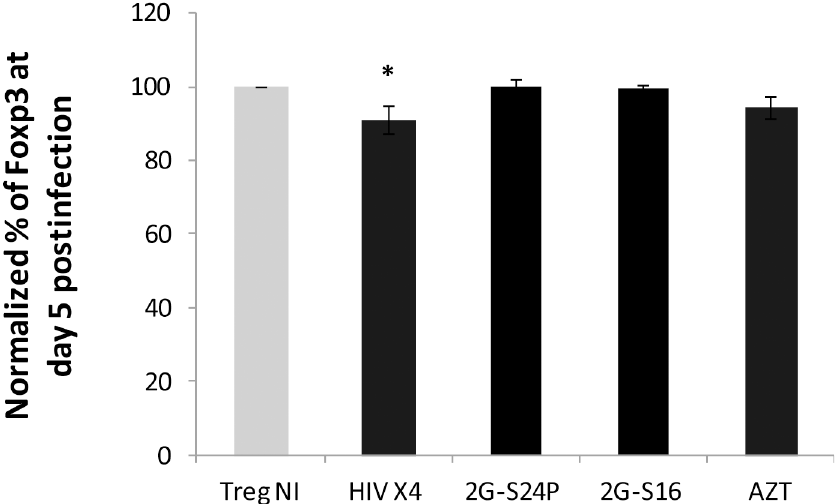
Fig 6. Foxp3 expression in Treg cells infected with HIV-1. Mean ± SEM values of frequency of Foxp3 in Treg infected with X4-tropic HIV NL4.3 (MOI 0.1), HIV NL4.3 + 2G-S24P (10 μ M), HIV NL4.3 + 2G-S16 (10 μ M)